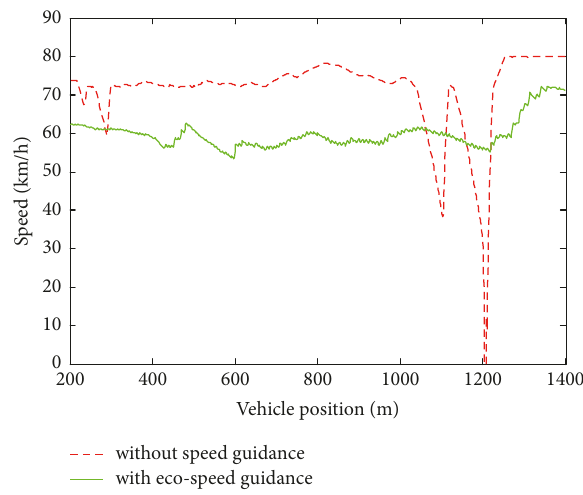
Figure 6: Velocity trajectory comparisons with and without speed